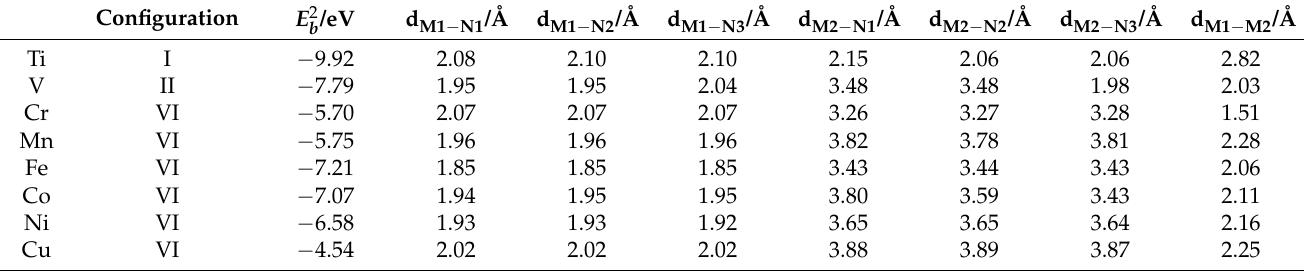
Table 3. The most stable configuration, binding energy ( 𝐸 (cid:3029)(cid:2870) ), the distance between the anchored metal atoms (Mx) and N atom (d Mx − Nx ) (M1 denotes the first metal atom, whereas M2 denotes a second attached atom), and the metal–metal distance of M1 − M2 (d M1 − M2 ).